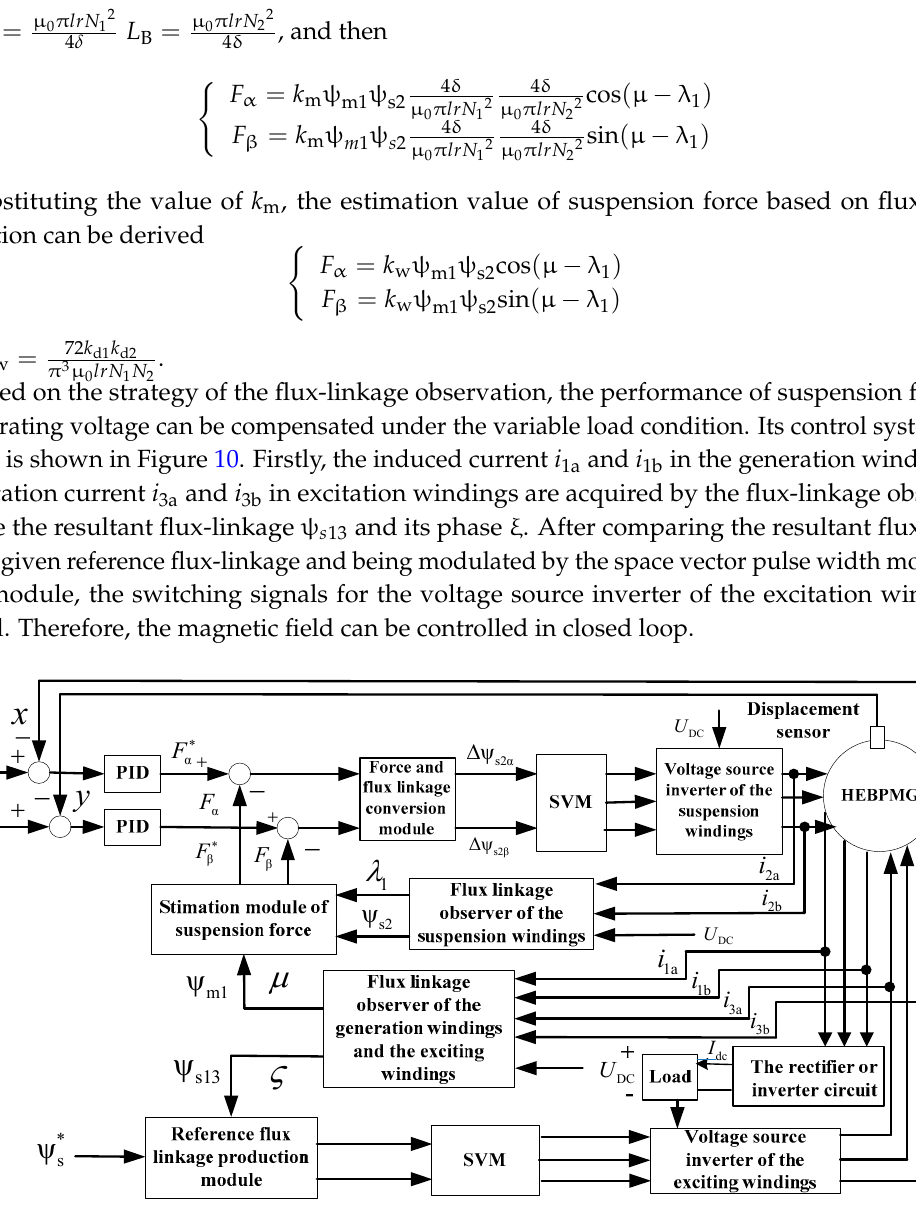
Figure 10. The compensation control block diagram of the flux ‐ linkage observation.